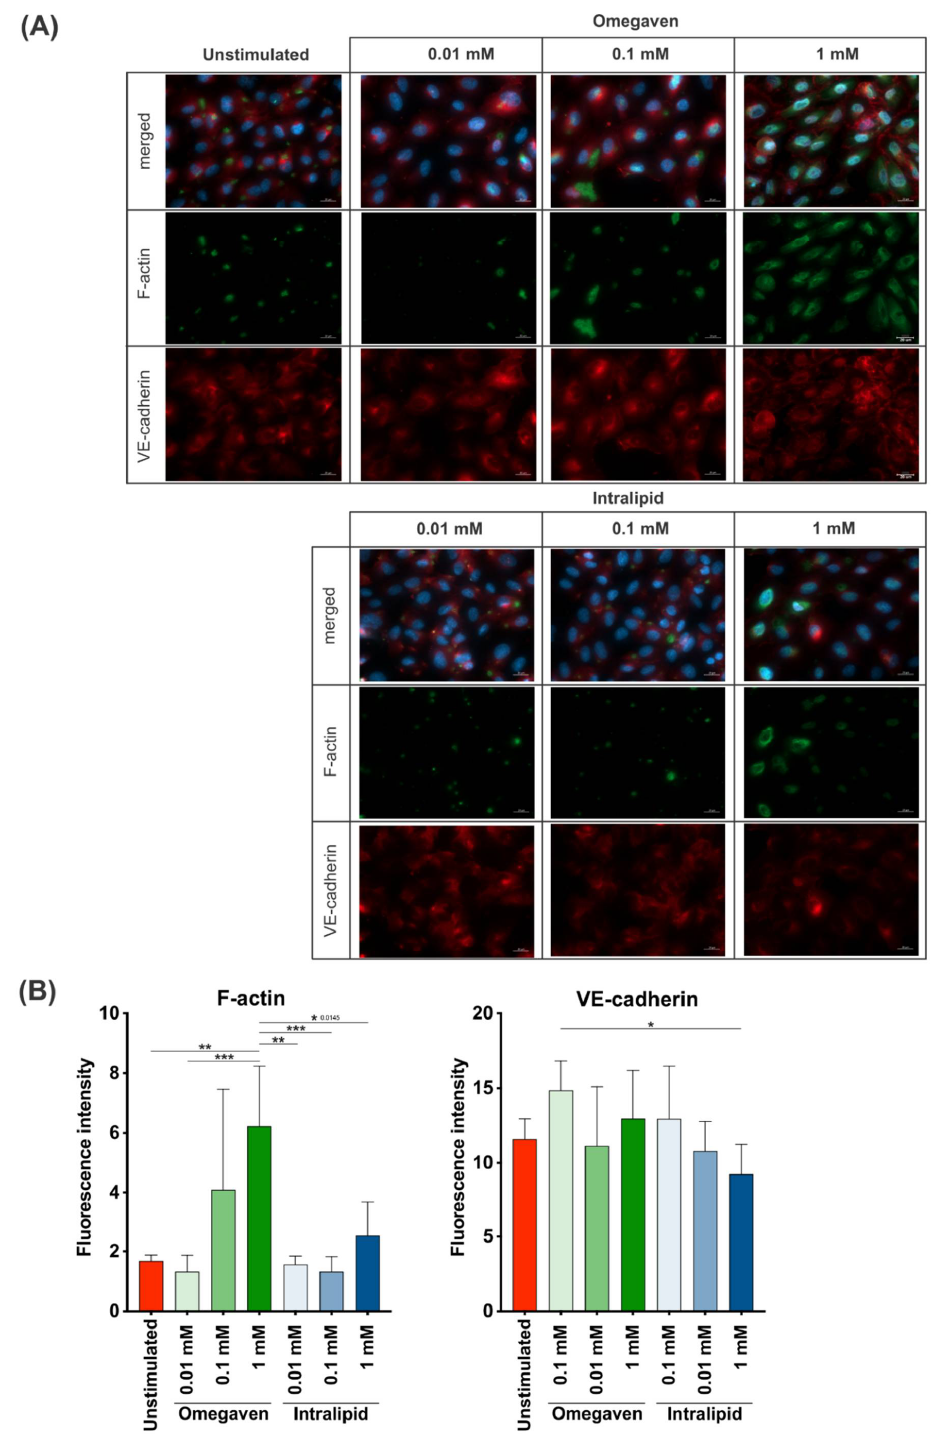
Figure 4. Omegaven ® at high doses but not Intralipid ® increases the F-acting formation and induces the formation of stress fibers in endothelial cells. Omegaven ® and Intralipid ® lipid emulsions at 0.01, 0.1 and 1 mM concentrations were added to confluent endothelial cells for 2 h. Cells were stained with anti-VE-cadherin (red) and anti-F-actin (green) antibodies ( A ). Images were acquired at 40 × magnification (scale bar 20 um). Fluorescence intensity for F-actin and VE-cadherin staining ( B ) was measured with ImageJ (National Institutes of Health, Stapleton, NY, USA). Five random images acquired for each experimental condition at 40 × magnification were used for quantification. (* p ≤ 0.05, ** p ≤ 0.01, *** p ≤